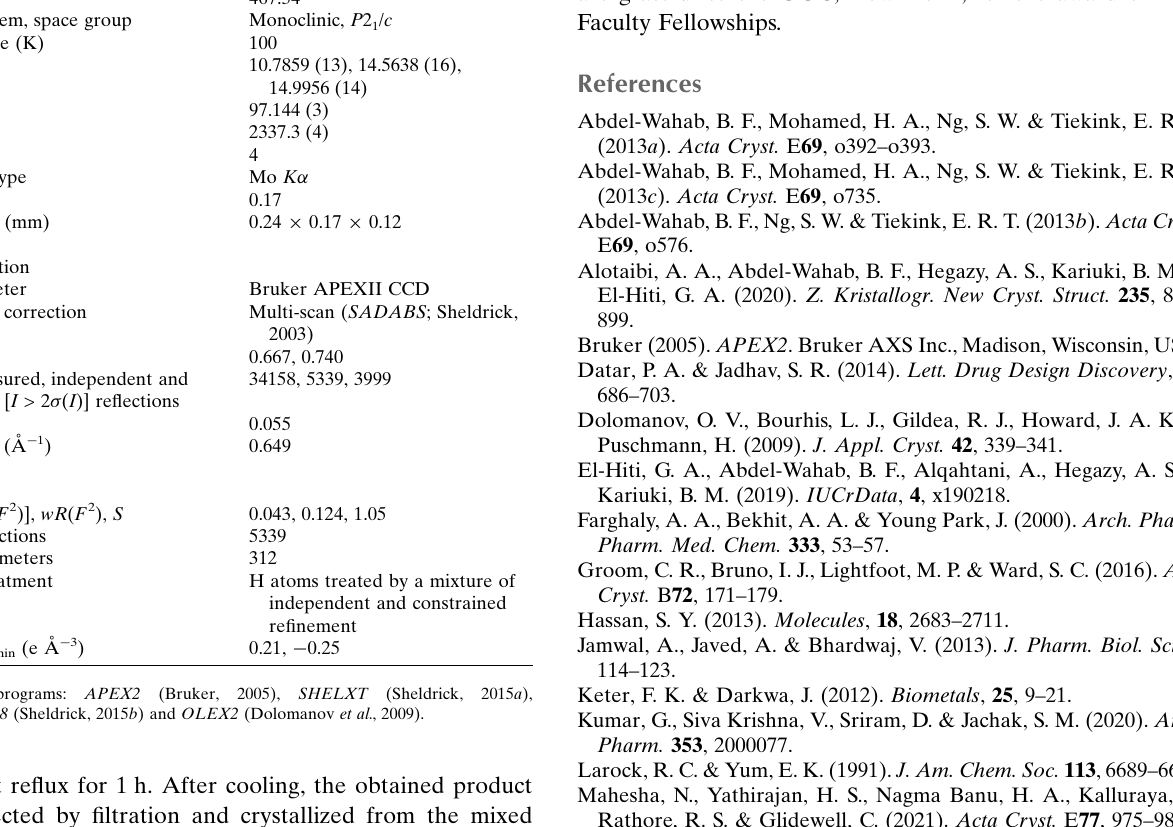
Table 2 Experimental details. Crystal data Chemical